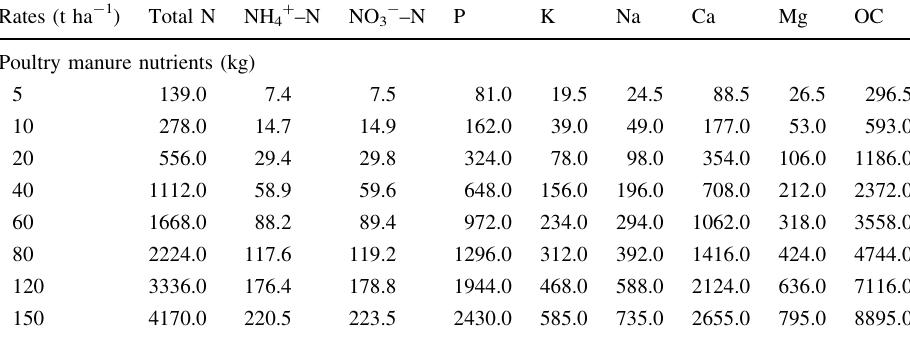
Table 4 Equivalent amount of nutrients present in poultry manure rates added to the